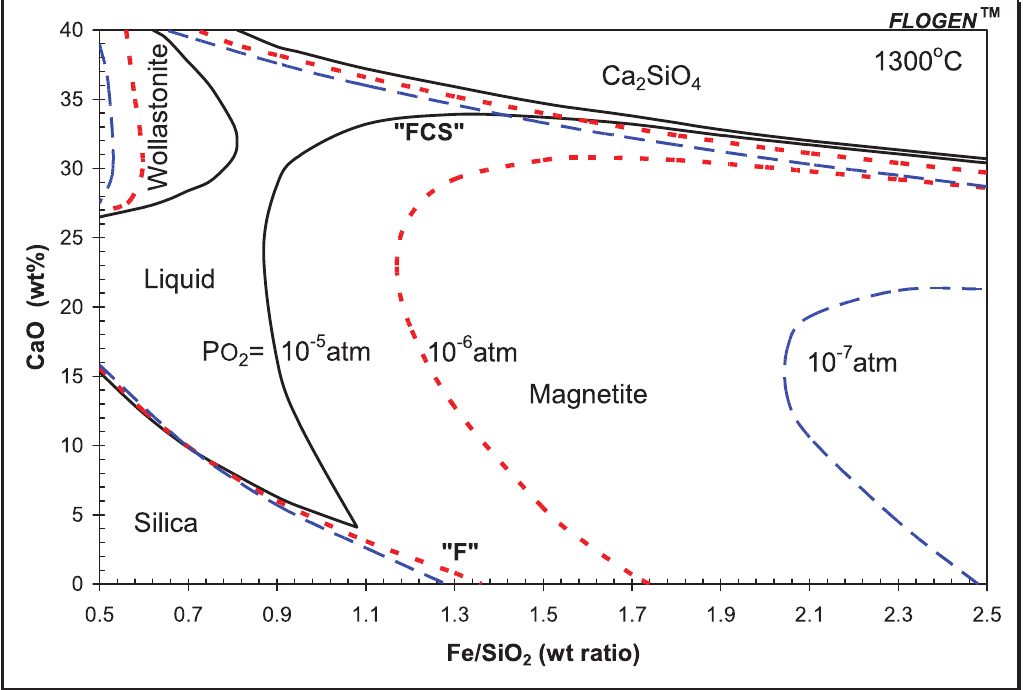
Figure 3. Effect of oxygen potential on the liquid regions of “fayalite” (“F”) and “ferrous calcium silicate”